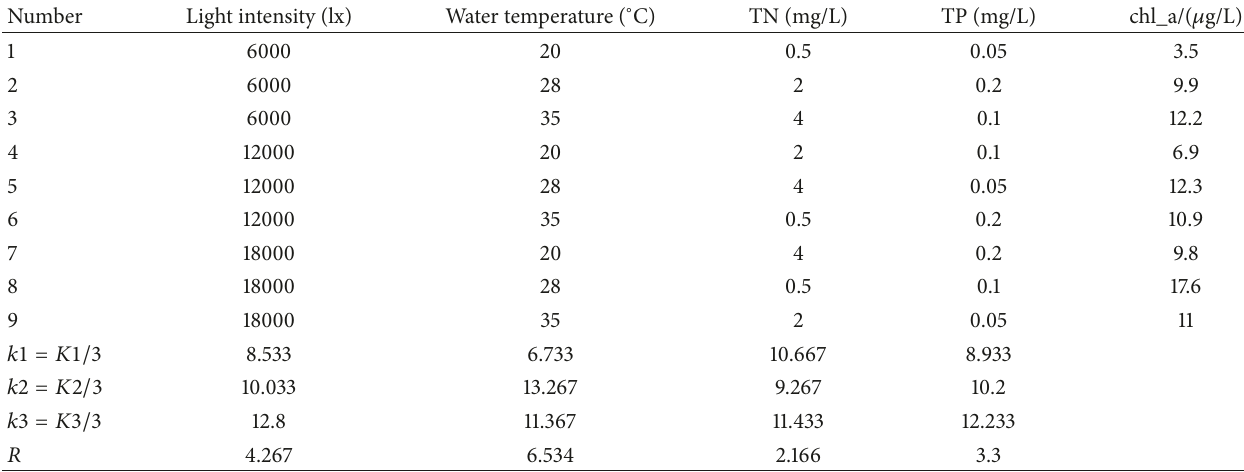
Table 5: L 9 (3 4 ) orthogonal experiment range analysis of the maximum daily growth rate of